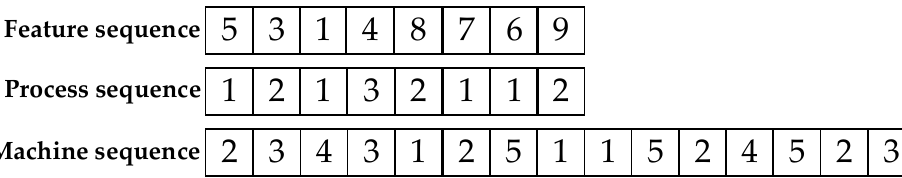
Figure 4. An example of hierarchical coding method for process planning problems.